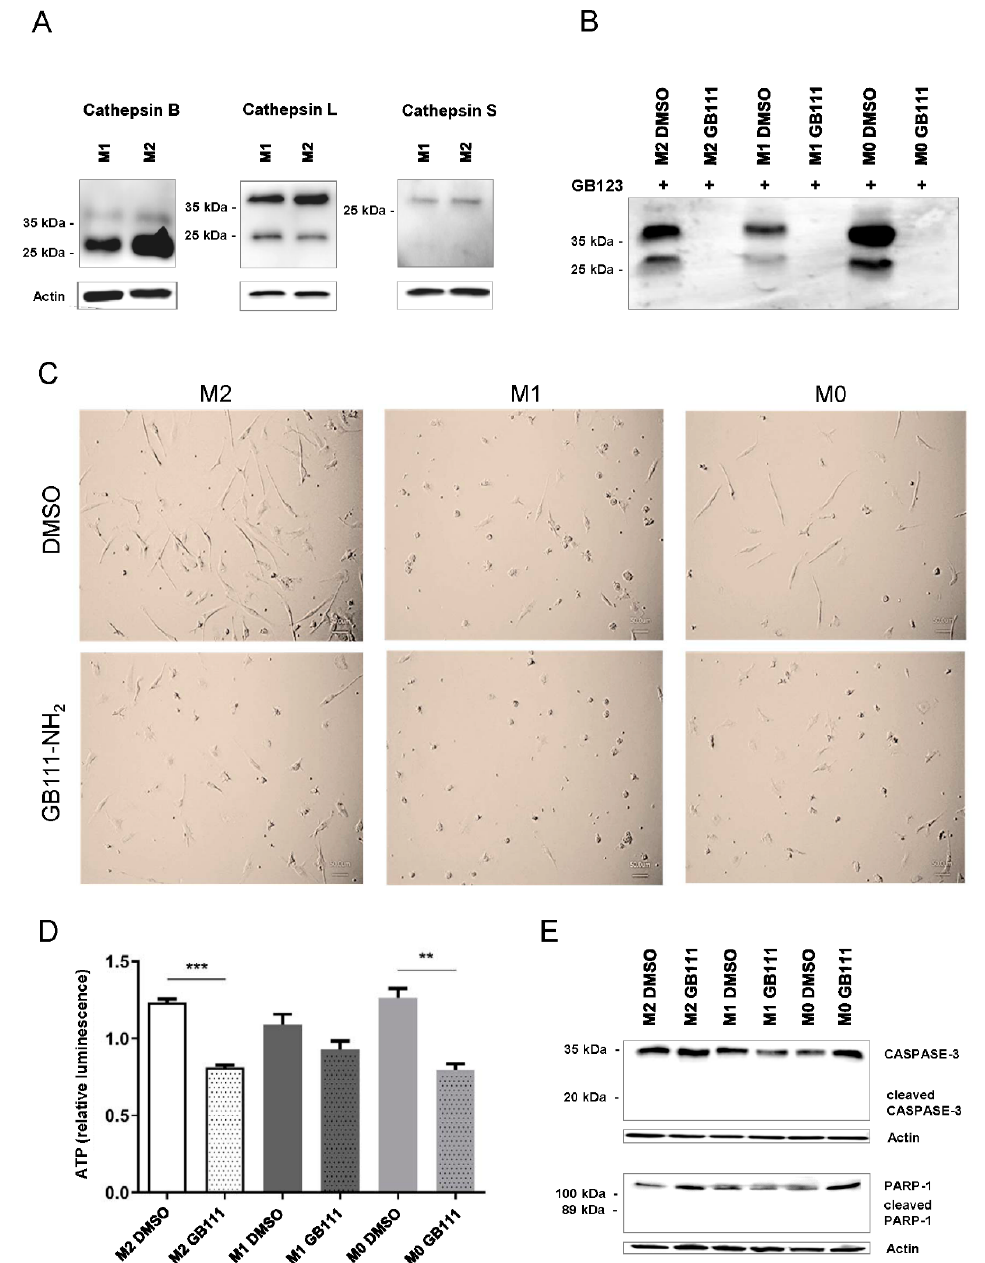
populations (Figure 2B).